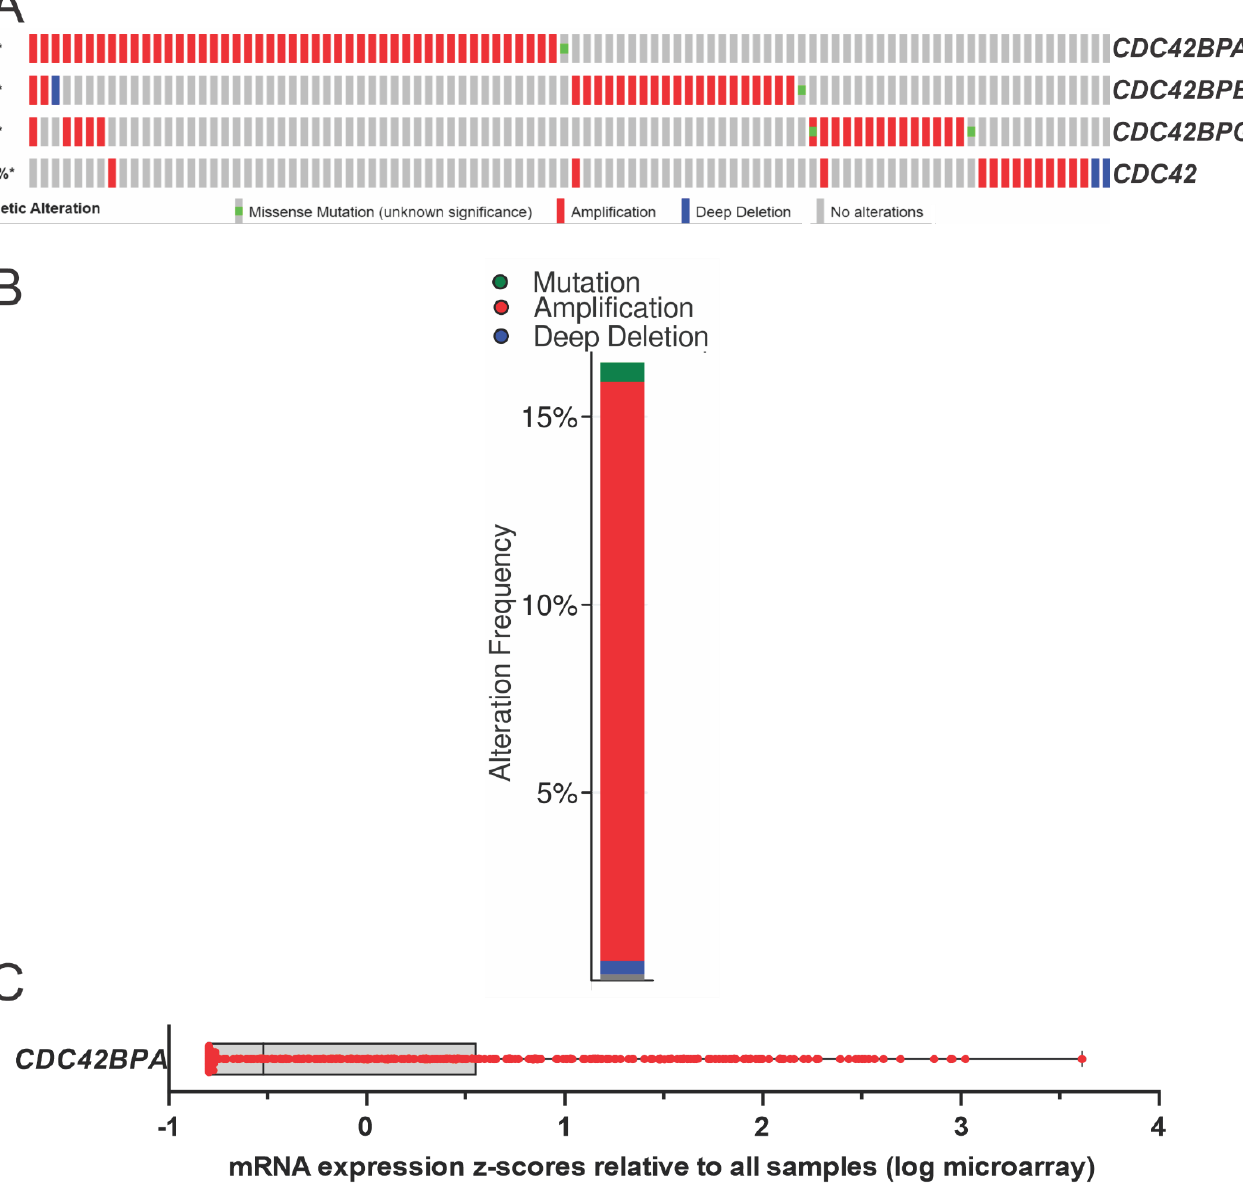
Figure 5. MRCK expression and gene mutations in ovarian cancers . ( A ). The Cancer Genome Atlas program was queried via cBioPortal for genomic alterations to the genes encoding Cdc42BPA, Cdc42BPB, and Cdc42BPG, and their upstream regulator Cdc42 in the TCGA studies of ovarian cancer [45,46]. ( B ). Cumulative plot of the genomic alterations to Cdc42BPA, Cdc42BPB, Cdc42BPG, and Cdc42. * indicates that values have been rounded to the nearest integer value. ( C ). Elevated MRCKα mRNA expression in ovarian cancer tumours determined by microarray. Log-transformed mRNA expression z-scores compared with the expression distribution of all samples, as determined with Agilent microarrays for 558 serous ovarian cancer patient samples in the TCGA Firehose database. The box indicates the upper and lower quartiles, with the line indicating median values.